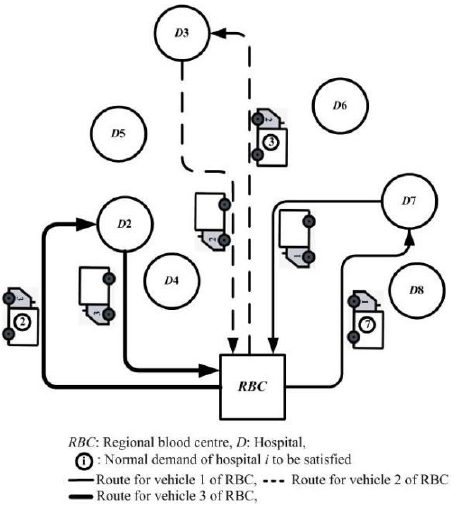
Fig. 1. The current centralized distribution in a single period